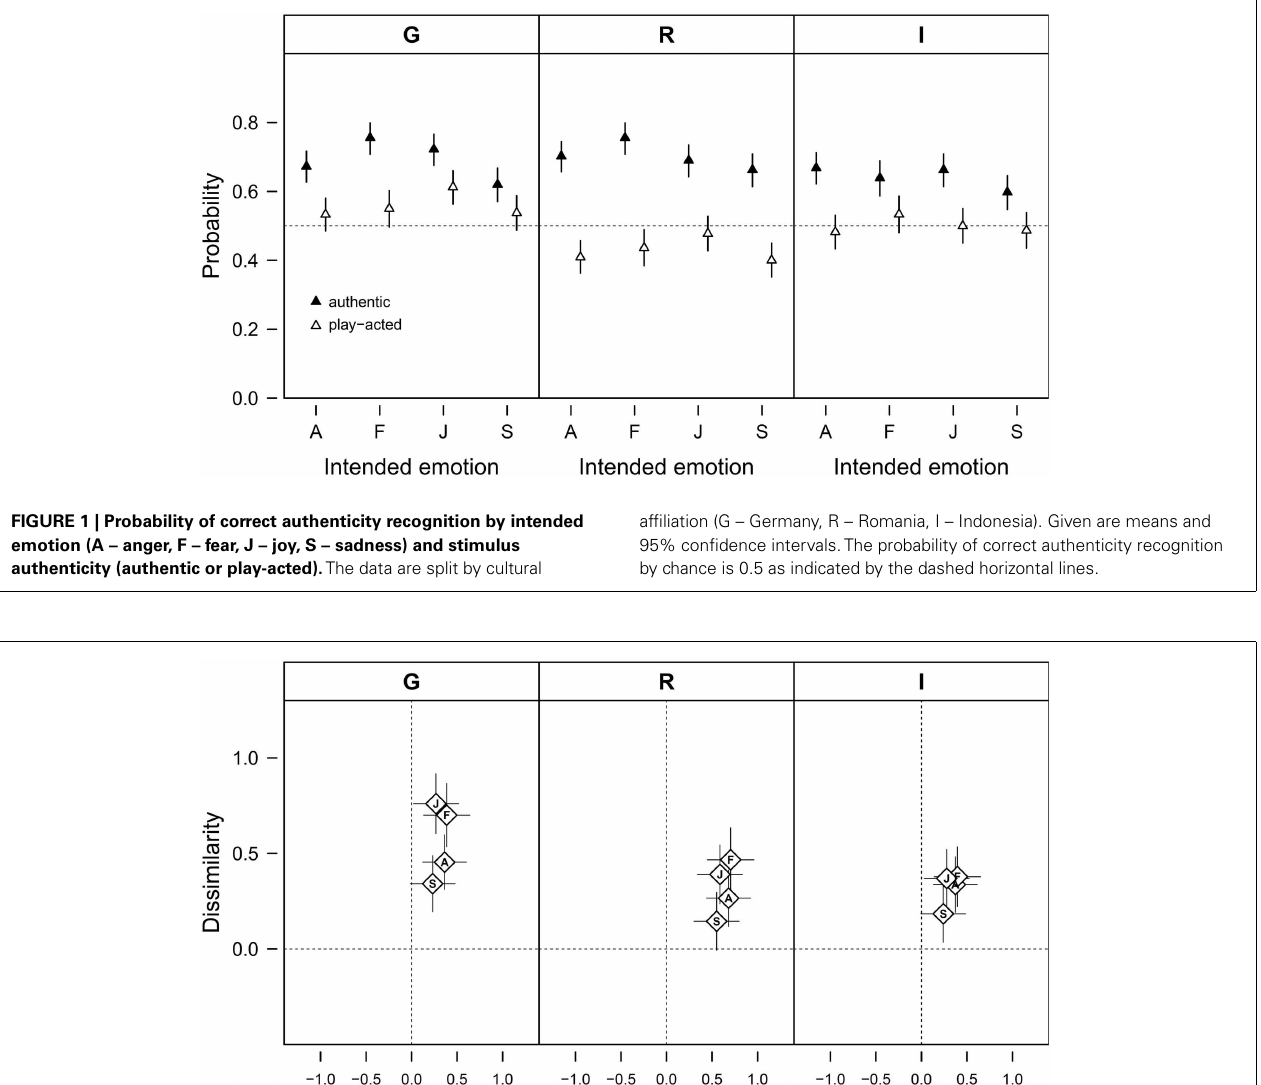
dependence of cultural affiliation (G – Germany, R – Romania, I – Indonesia) and the intended emotional content (A – anger, F – fear, J – joy, S – sadness). Positive values on the x -axis indicate a bias toward preferentially choosing the response “authentic,” while higher dissimilarity values indicates a better ability to distinguish the stimuli. Data are given are as means ± 95% confidence